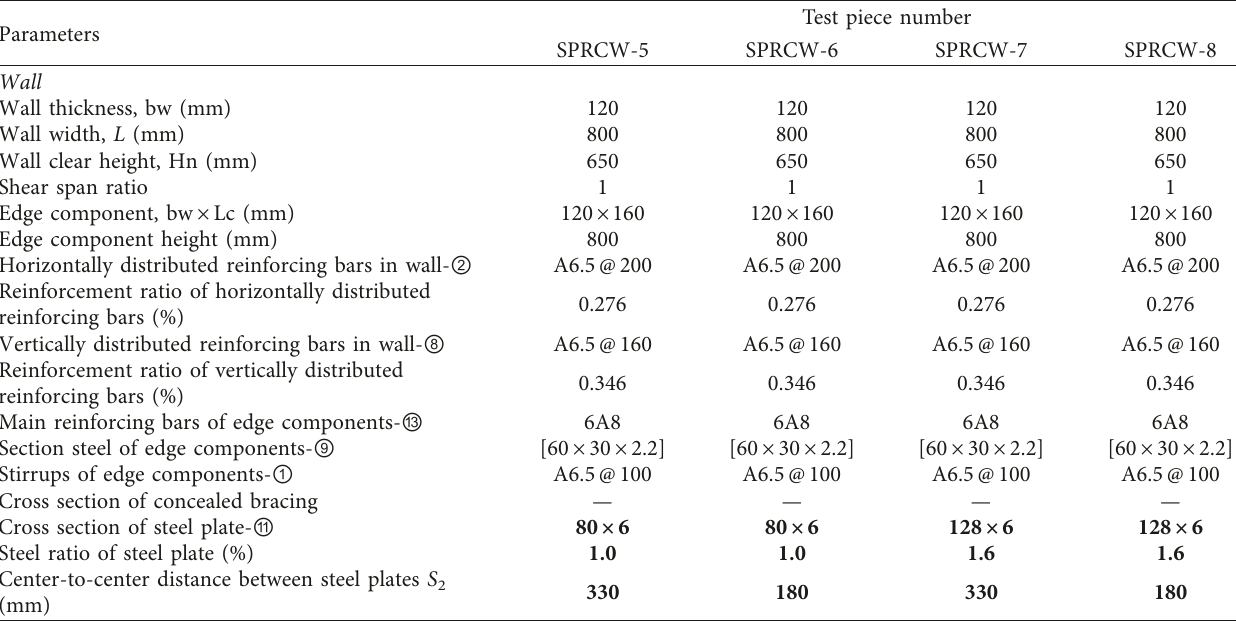
Table 1: Test piece